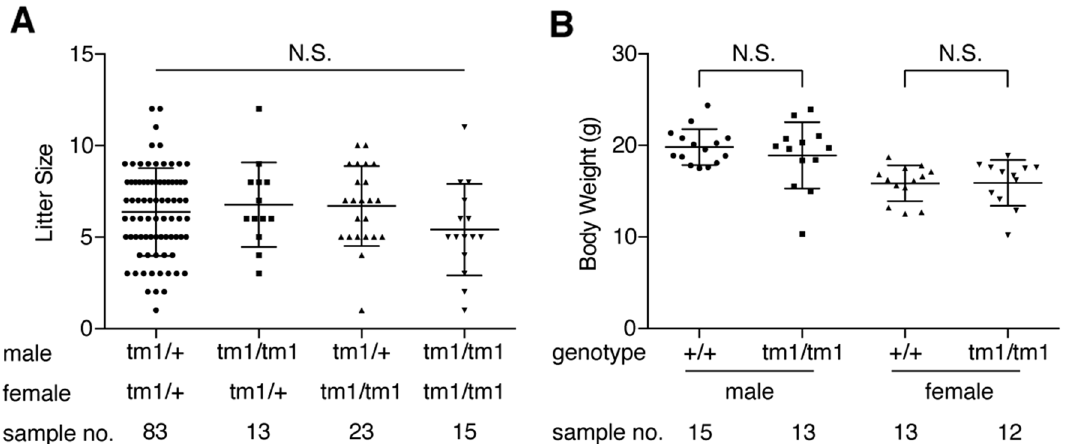
Figure 3. ( A ) Litter size of Zfta tm1/ + (tm1/+) and Zfta tm1/tm1 (tm1/tm1) breeding pairs. Data shown are the mean ± SD. Each point on the graph is the size of an individual litter. N.S., not significant ( p = 0.35). ( B ) Body weight of WT (+/+) and Zfta tm1/tm1 (tm1/tm1) mice at P30–32. Data shown are the mean ± SD. Each point on the graph is the weight of an individual mouse. N.S., not significant (male, p = 0.41; female, p =